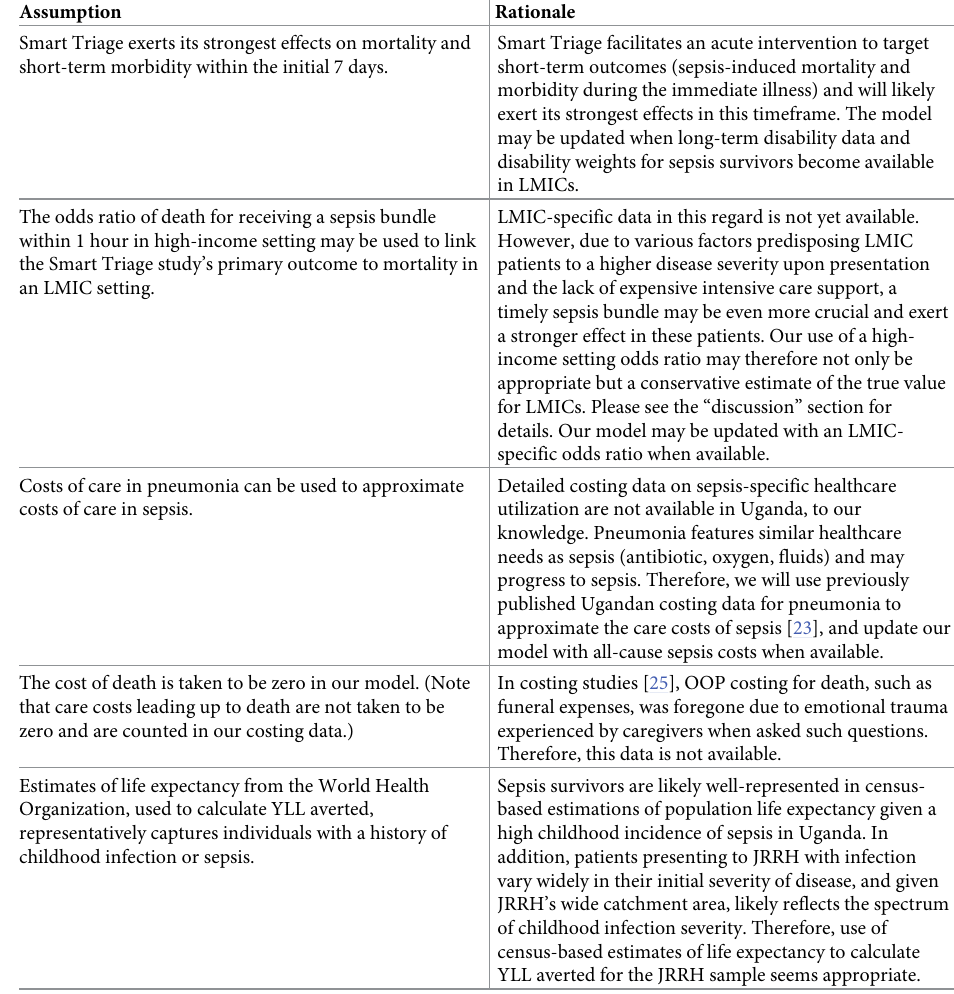
Table 1. Key assumptions of the decision analytic